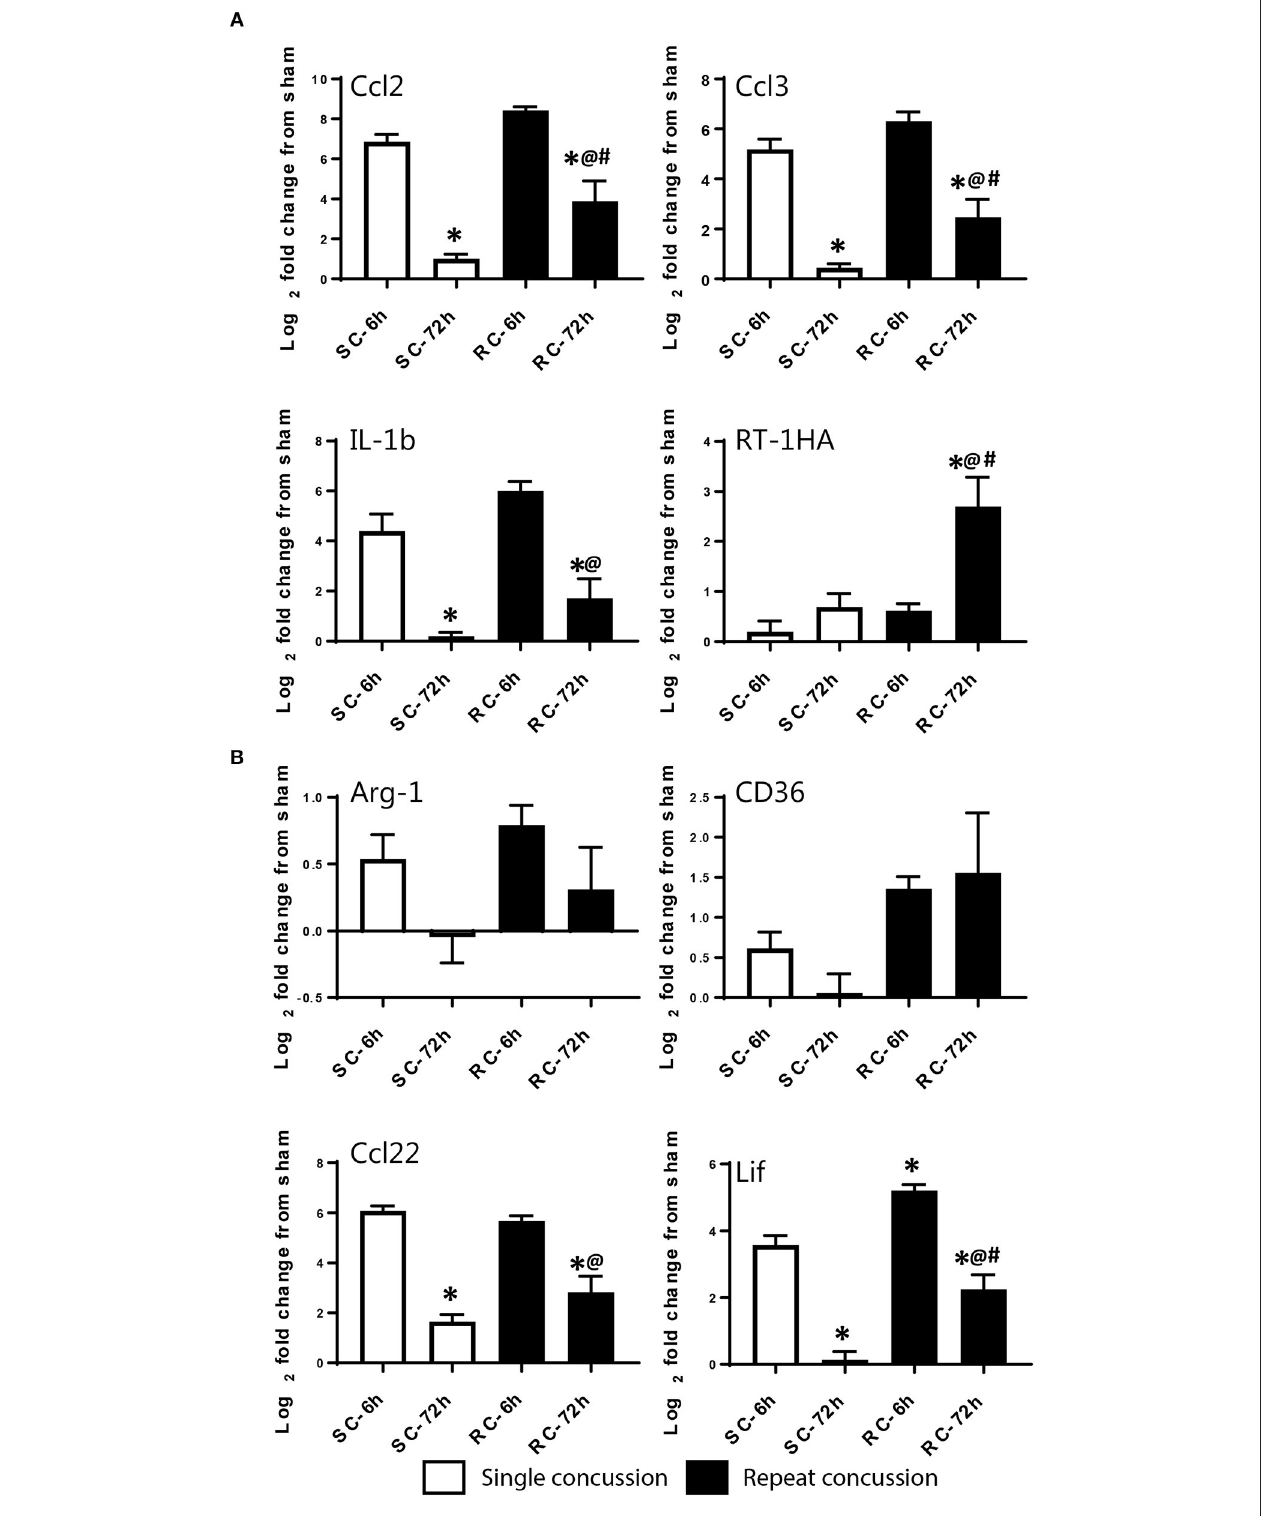
FIGURE 6 | Single gene qRT-PCR of selected targets in the ipsilateral cortex. Selected gene targets including both (A) M-1 and (B) M-2 markers are run separately using individual samples ( n = 10/condition). RT-1HA was included as this is part of MHC-II complex. One-way ANOVA with Tukey’s post-hoc test. *p < 0.05 compared to single hit 6h. @ p < 0.05 compared to repeated hit 6h. # p < 0.05 compared to Single hit 72h. SC: single concussion, RC: repeated concussion, CX: cortex.